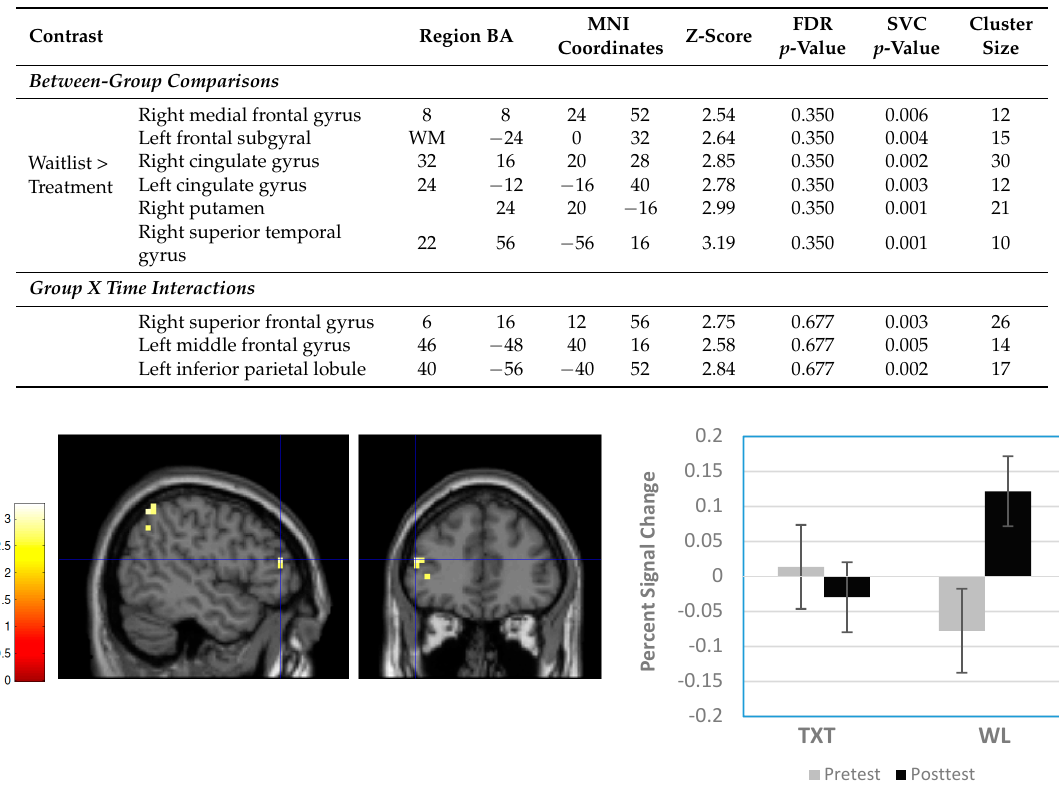
Figure 3. Sample Group × Time interaction result from whole-brain analysis. Panel on left shows sagittal and coronal views of significant cluster in left middle frontal gyrus (Brodmann Area (BA) 46; Montreal Neurological Institute (MNI) coordinates = − 48 40 16). Panel on right shows percent signal change differences between groups. Note signal decreased between pre-test and post-test in TXT and increased in WL.